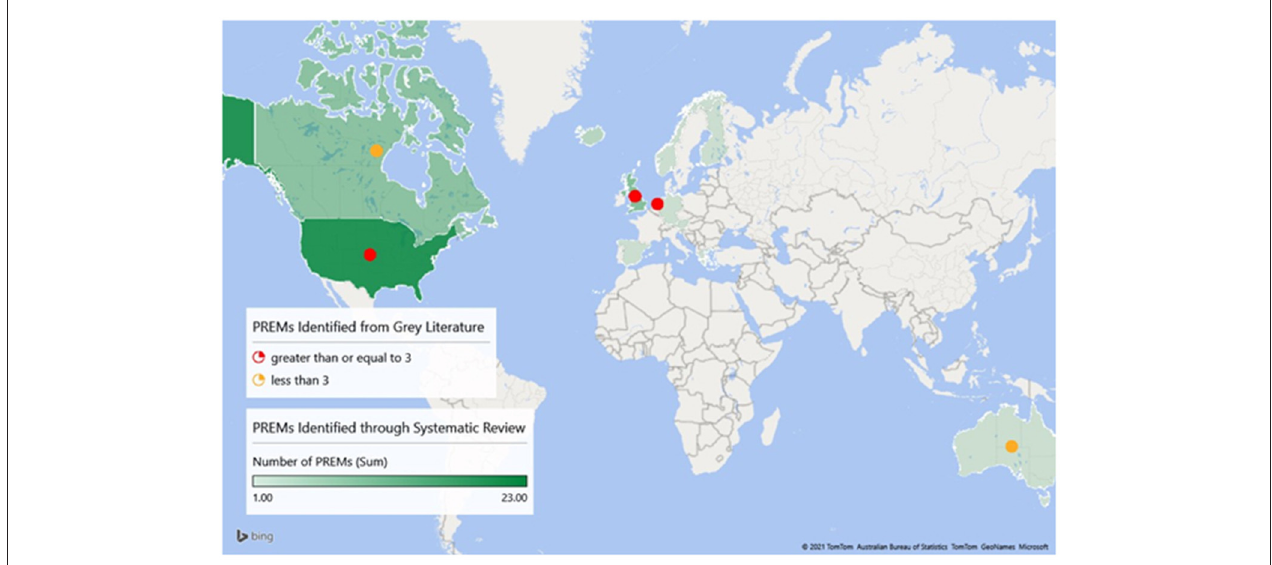
FIGURE 2 | Geographic locations of pediatric PREMs identified through systematic review and gray